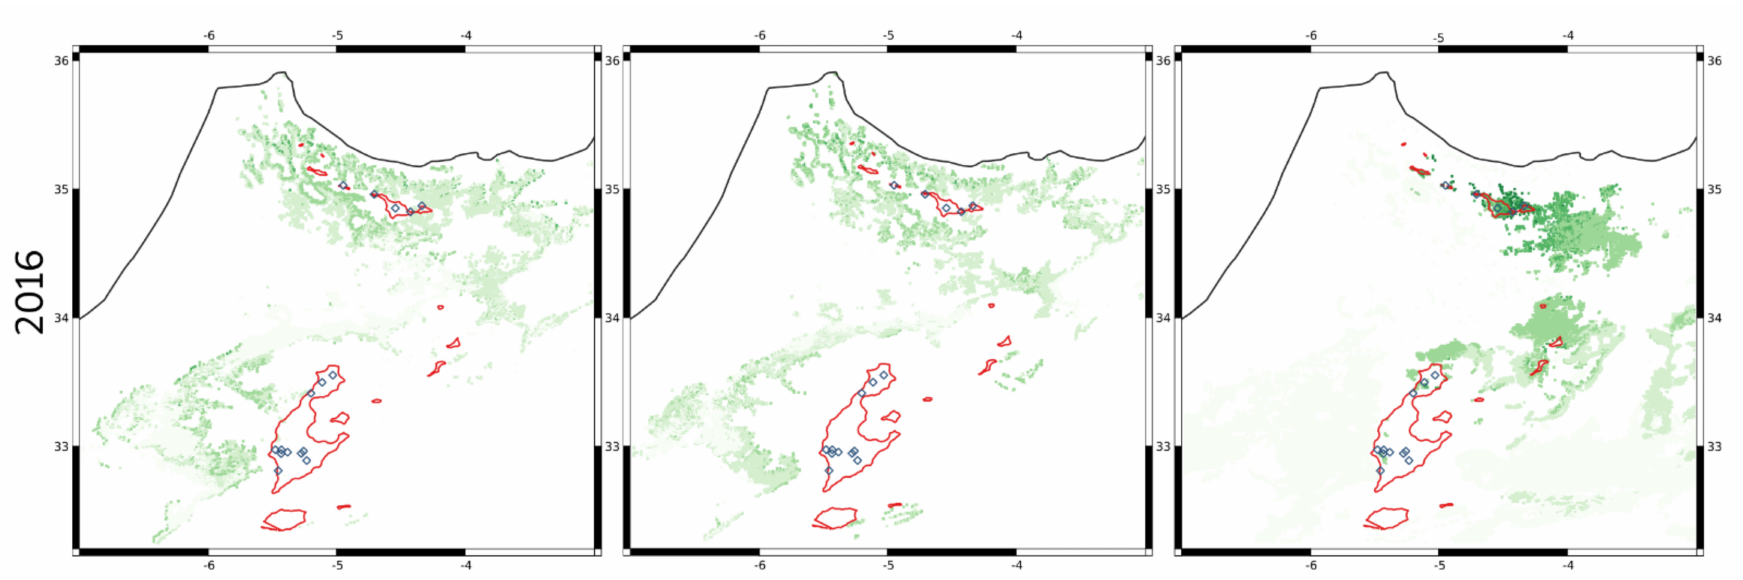
Figure 6. Examples of simulated net primary productivity annual distributions for selected years. Comparisons of simulation outputs using PFT traits , field mean traits or computed traits , with sampling locations (blue squares), and contours of the extant distribution (red